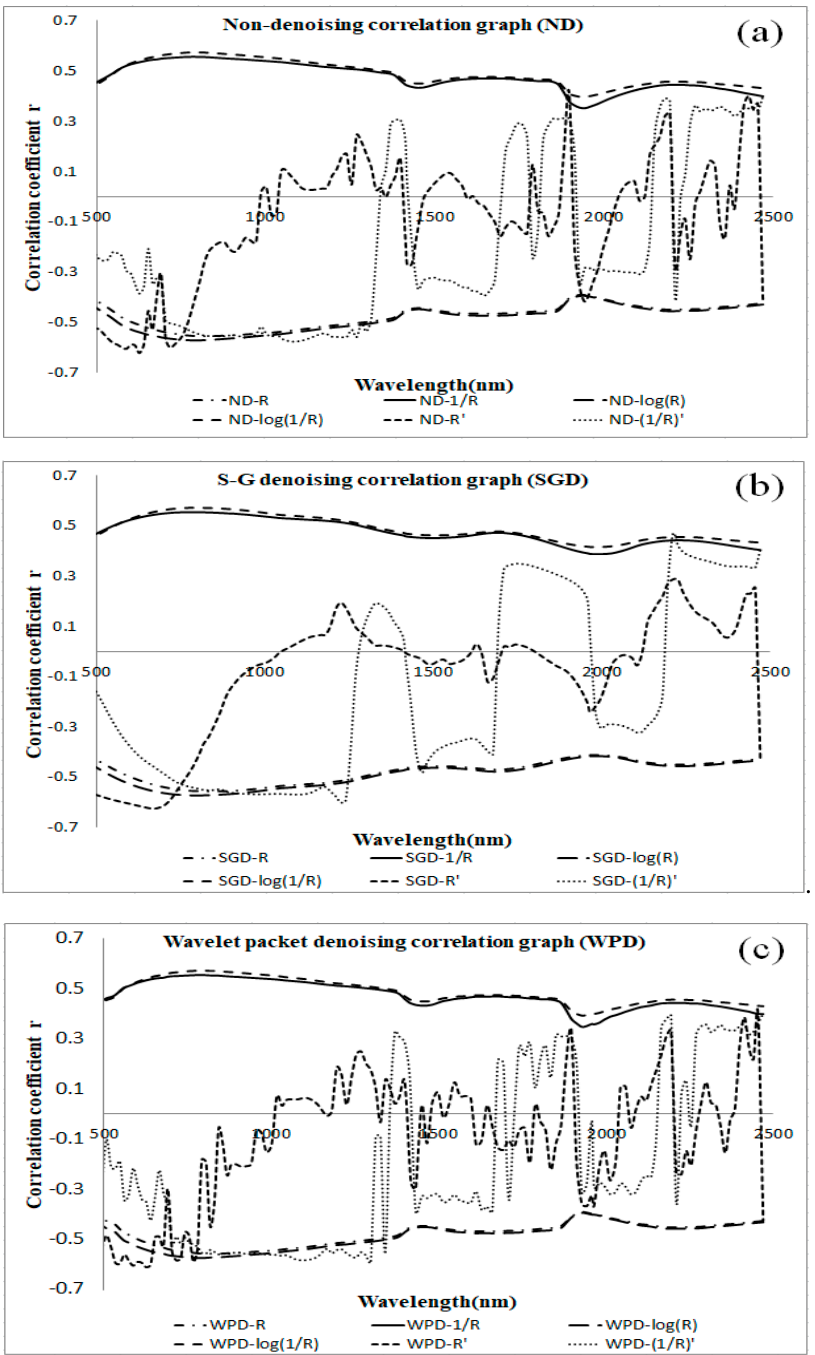
Figure 3. Curves for correlations between SOM content and spectral data subjected to six different transformations under ( a ) ND, ( b ) SGD, and ( c ) WPD at wavelengths of 400–2500 nm.